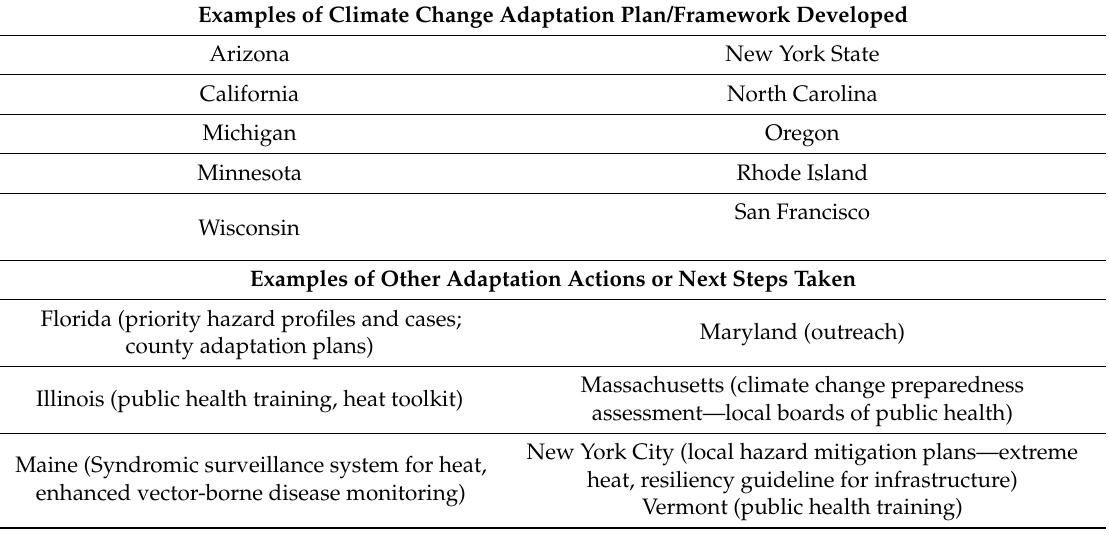
Table 2. Climate Change and Health Adaptation Plans or Actions Taken by the United States Centers for Disease Control and Prevention (U.S. CDC) Building Resilience against Climate Effects (BRACE) Climate-Ready States and Cities Initiative Participants.